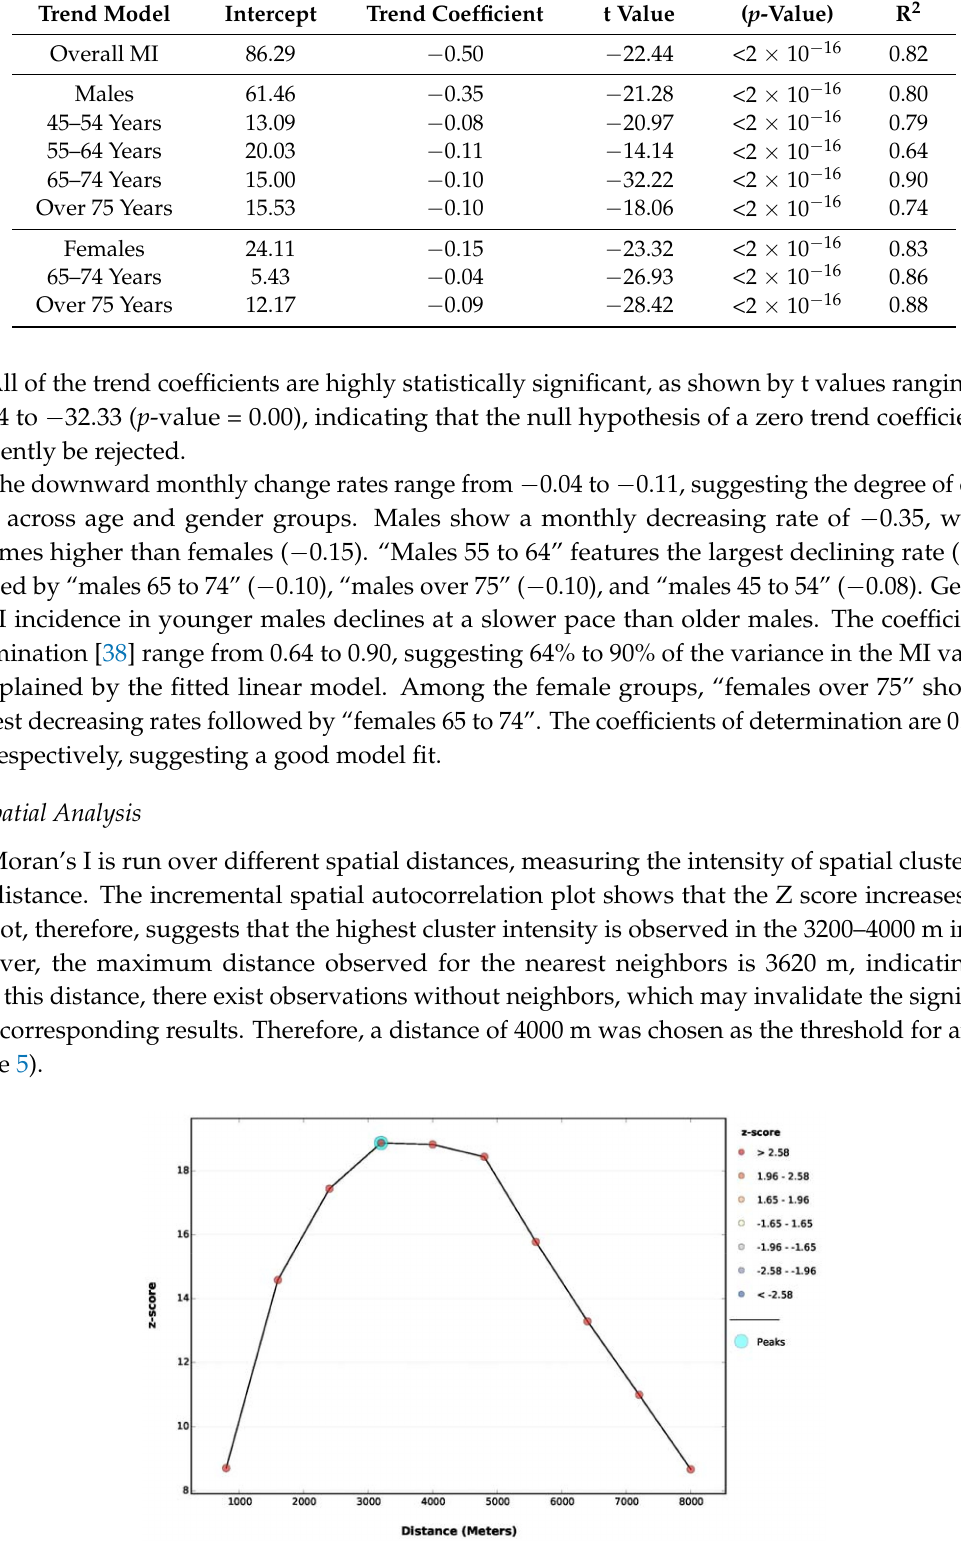
Figure 5. Spatial autocorrelation by distance for overall